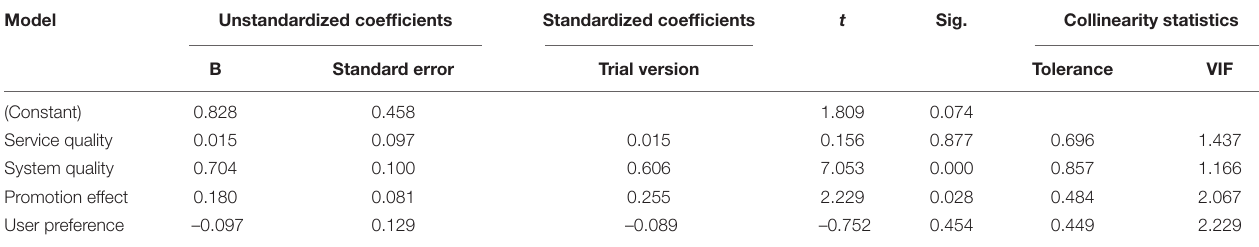
TABLE 4 | Multiple regression